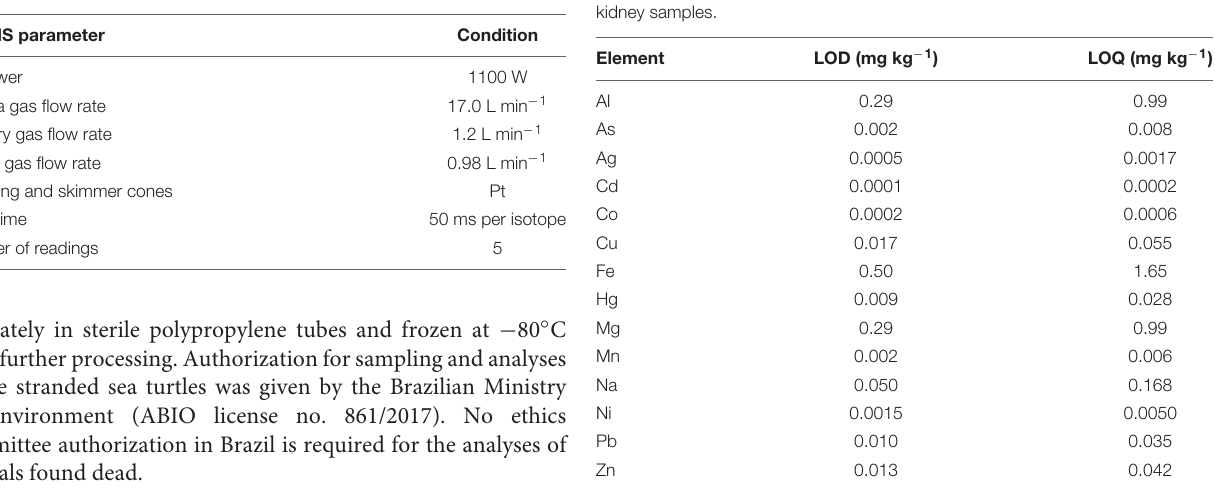
TABLE 1 | ICP-MS instrumental operating conditions applied in elemental determinations in green turtle ( Chelonia mydas ) muscle and kidney samples.